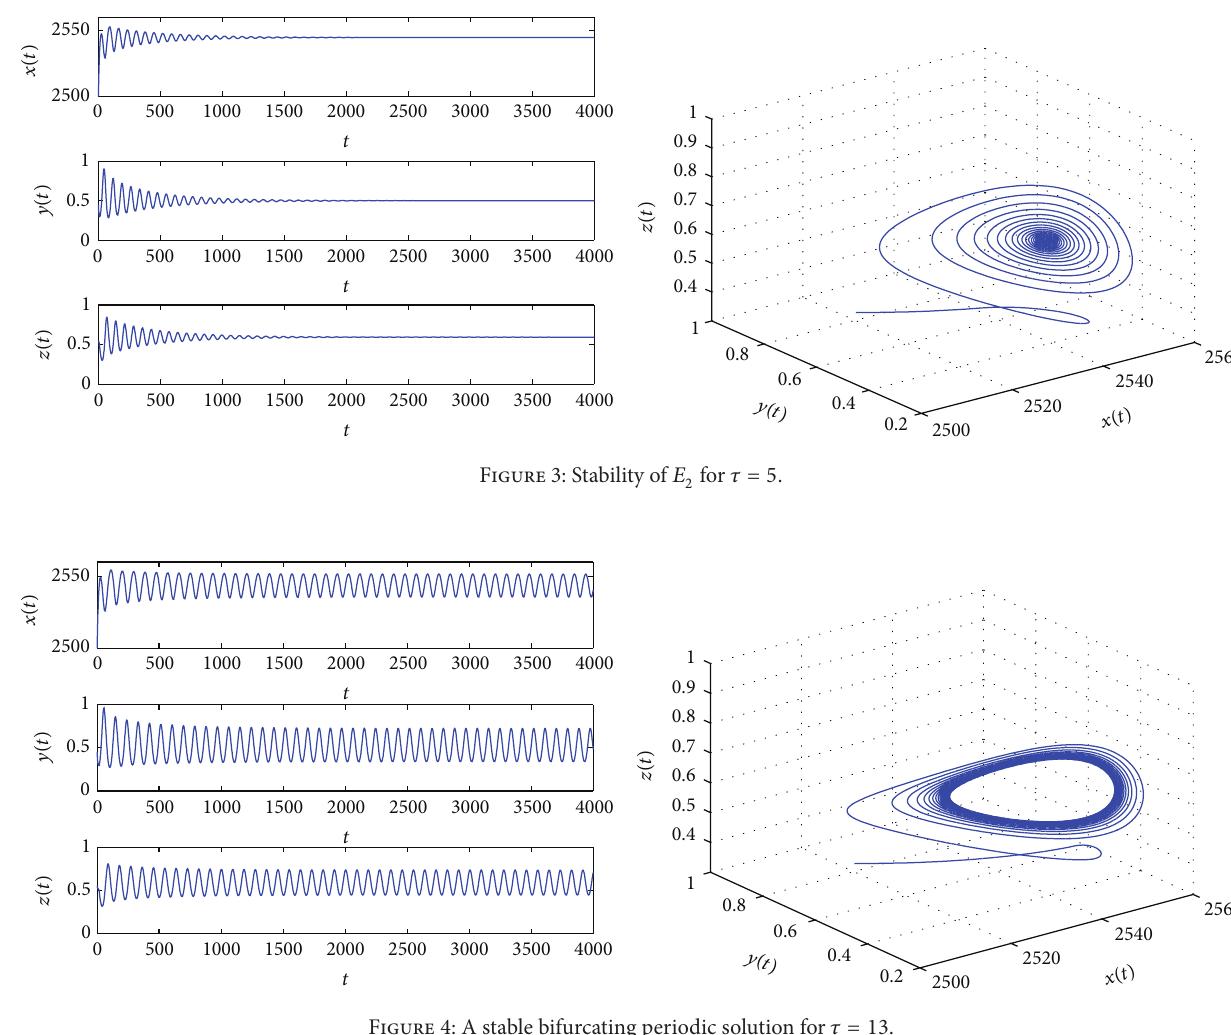
Figure 4: A stable bifurcating periodic solution for 𝜏 = 13